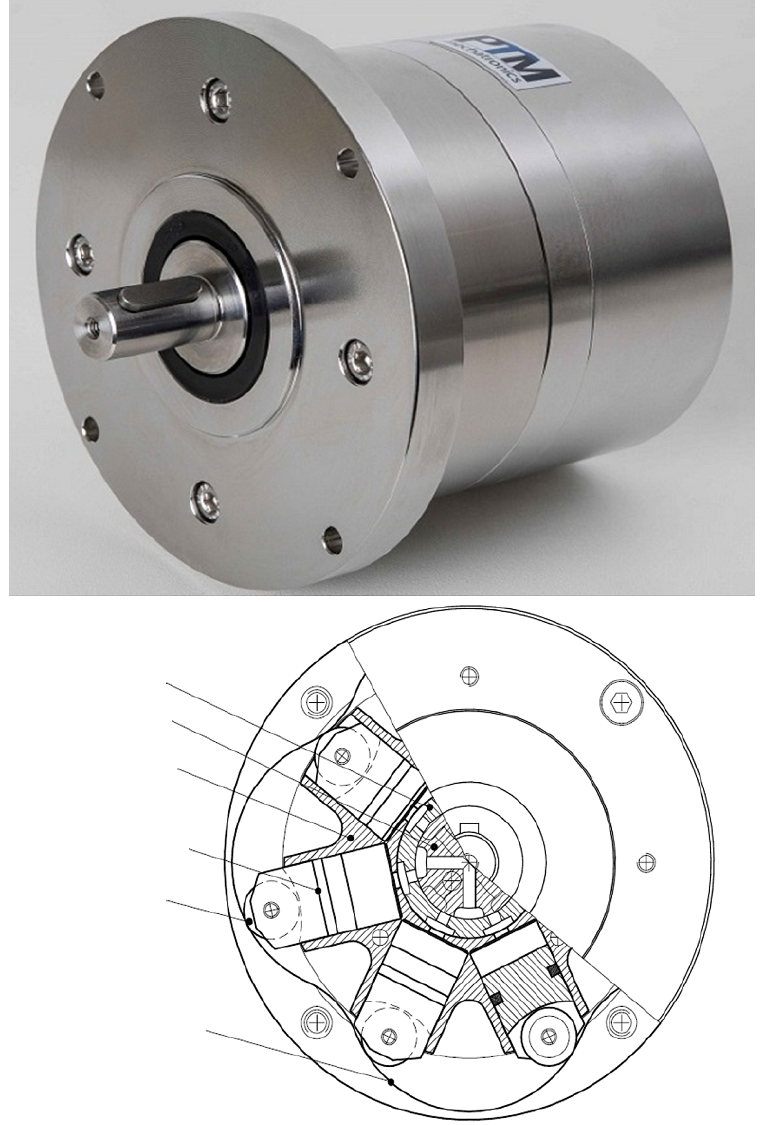
Figure 1. Photo and interior structure of the studied pneumatic